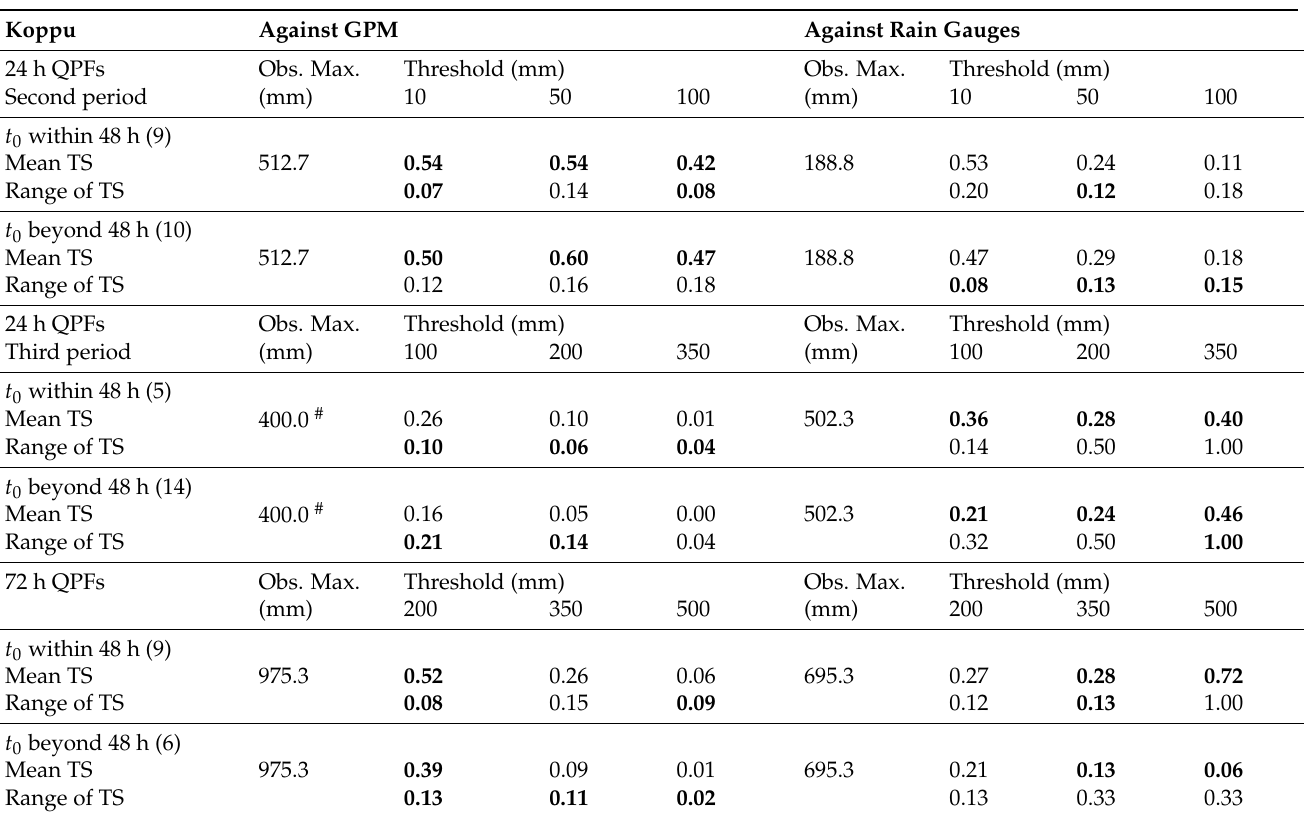
Table 3. As in Table 2, but for the comparison for TY Koppu (2015), in which the 24 h QPFs were for the second (1200 UTC on 17 to 1200 UTC on 18) and third (1200 UTC on 18 to 1200 UTC on 19) periods, and 72 h QPFs for 1200 UTC on 16 to 1200 UTC on 19 October